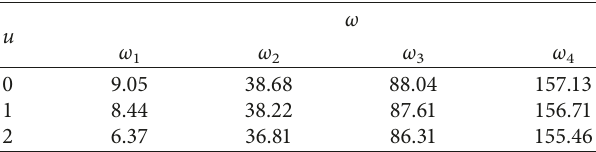
Figure 7: The deflections of the pinned-pinned pipe with different fluid velocities: (a) u � 0; (b) u � 1; (c) u � 2. Table 1: The dimensionless natural frequencies of the pinned- pinned